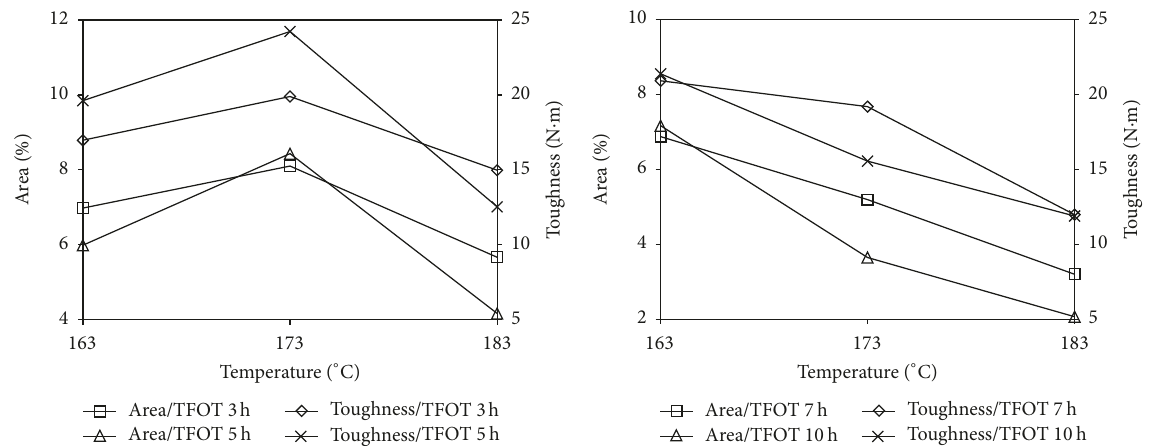
Figure 5: Correlation of SBS particle area and toughness with aging temperature.